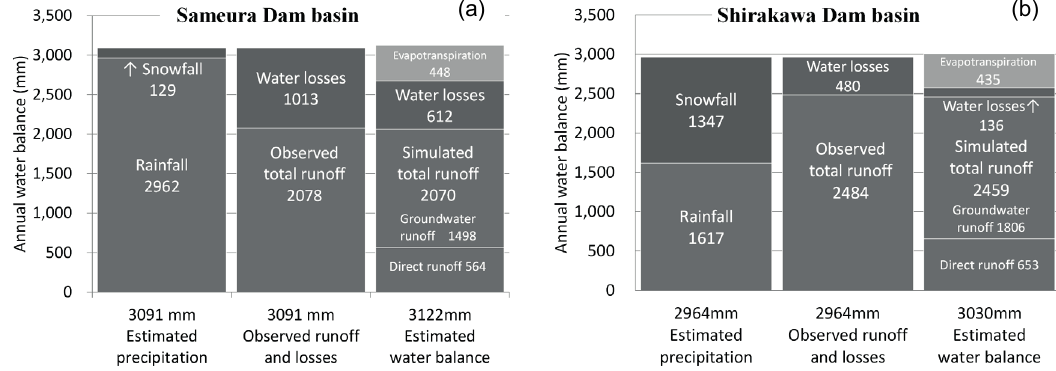
Fig. 6 Annual water balance for the SAME basin (a) and for the SIRA basin